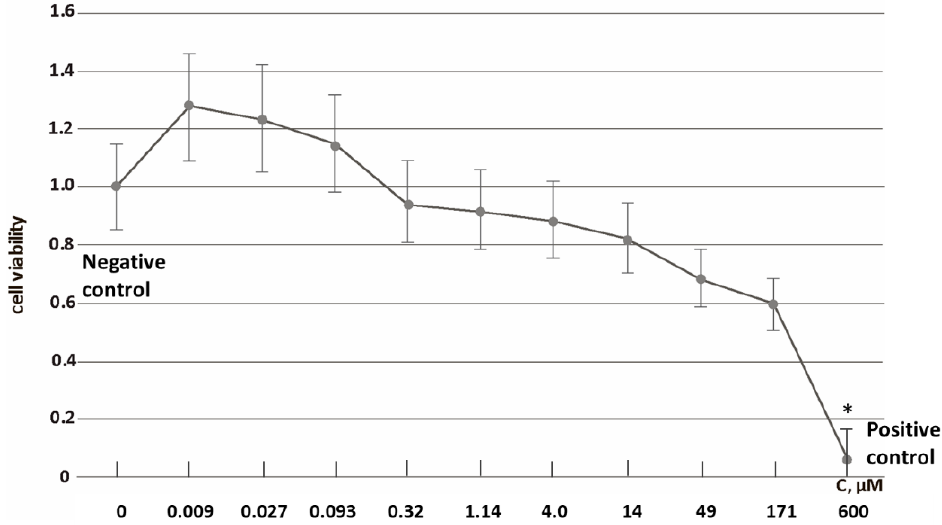
Figure 2. MTT-test result: the absorbance at 570 nm vs. F1 concentration. Significant differences with the negative control by the Mann−Whitney test ( p < 0.01) are denoted by “*”. the negative control by the Mann − Whitney test ( p < 0.01) are denoted by